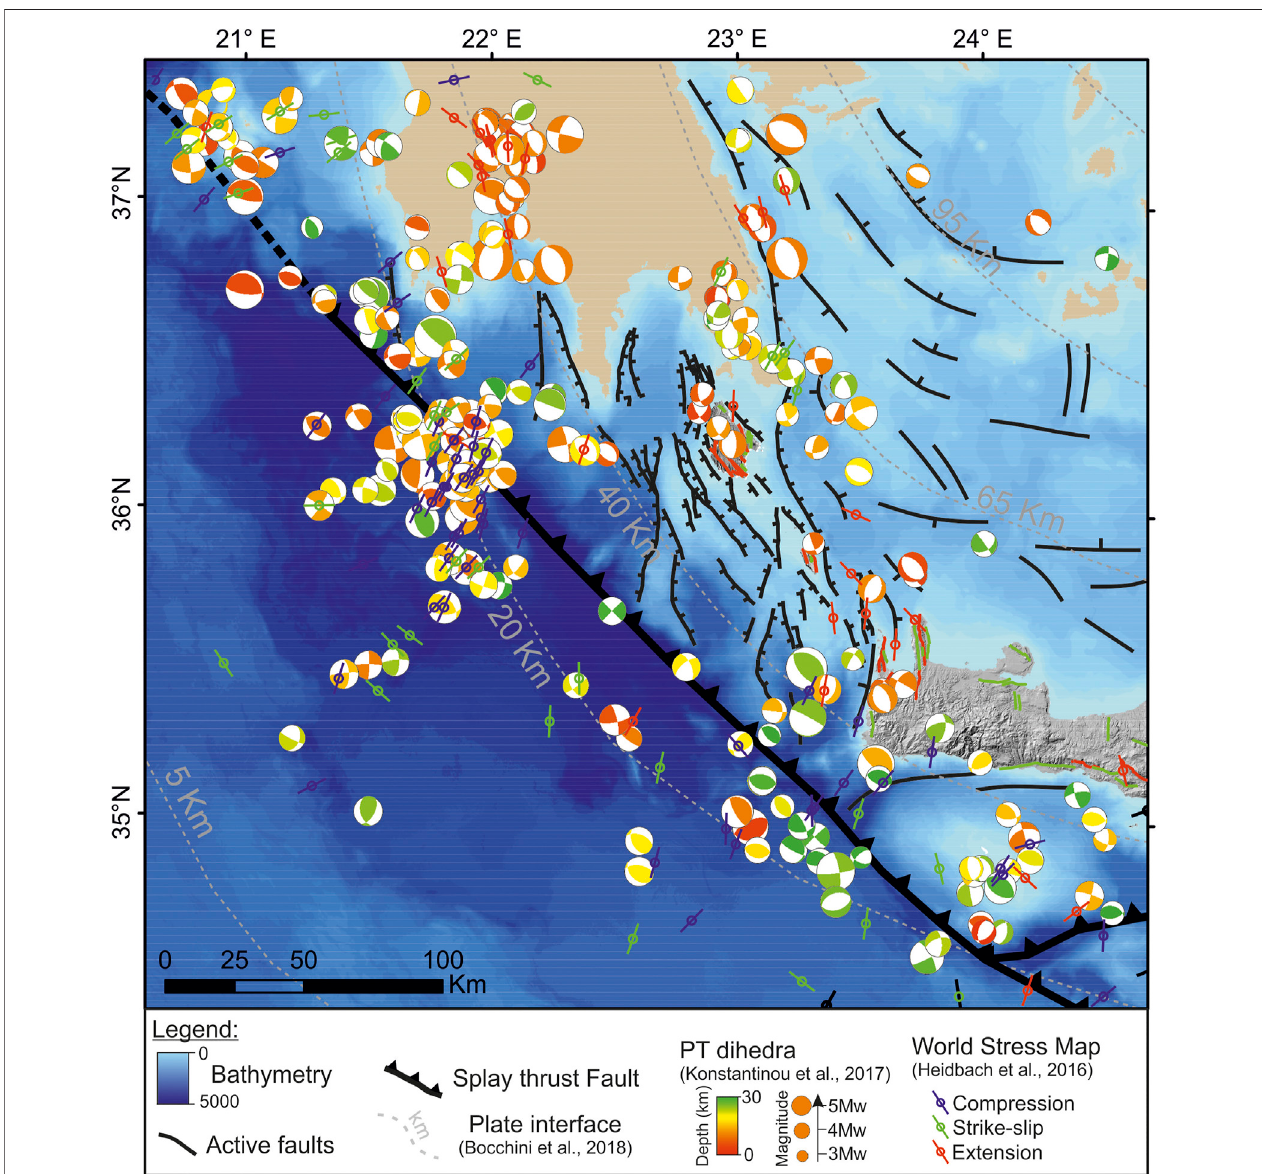
FIGURE 9 | Map illustrating the main normal faults along the southwest Hellenic Forearc (this study; Sakellariou and Tsampouraki-Kraounaki, 2019; Nicol et al. 2020a). Moment tensor solutions are from Kontantinou et al. (2017) and are colour-coded according to depth. Present-day stress fi eld indicators are from the World Stress Map Database (Heidbach et al., 2016) and are colour-coded according to stress regime.